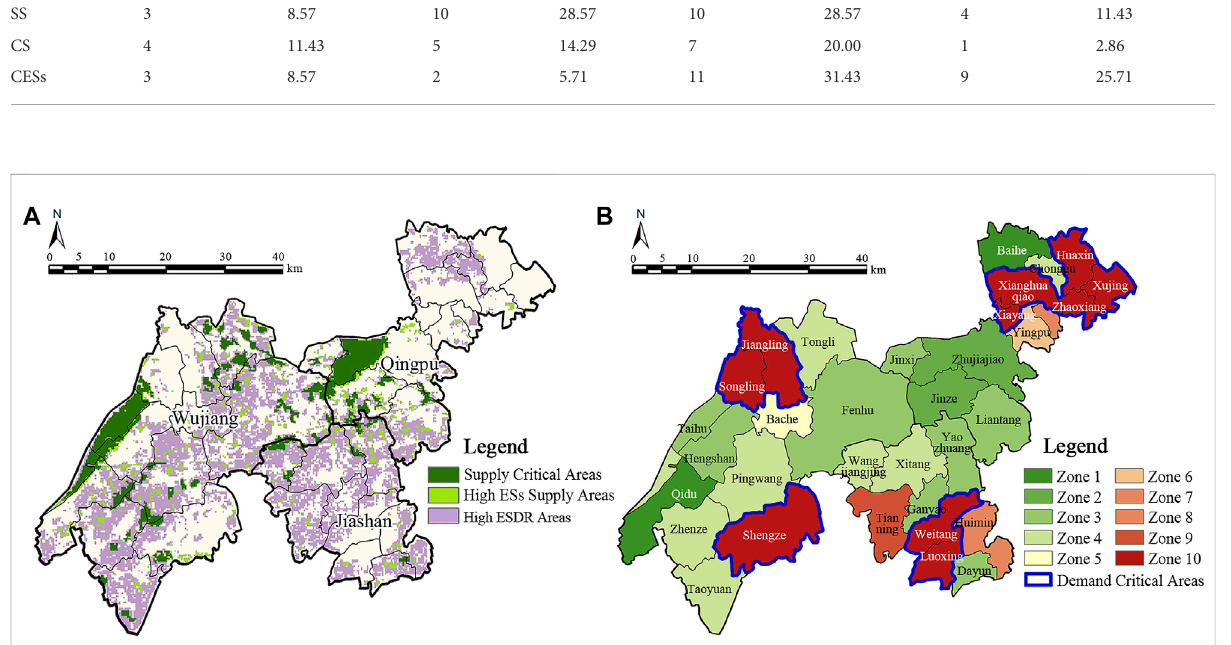
FIGURE 5 Spatial distribution of critical areas. (A) Critical areas of ES supply; (B) critical areas of ES